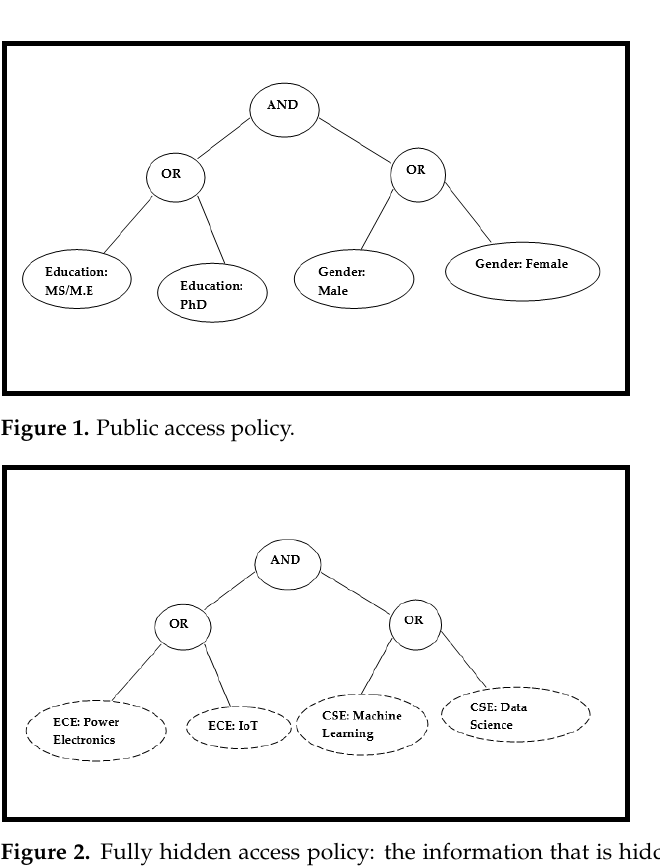
Figure 2. Fully hidden access policy: the information that is hidden is represented by the dotted